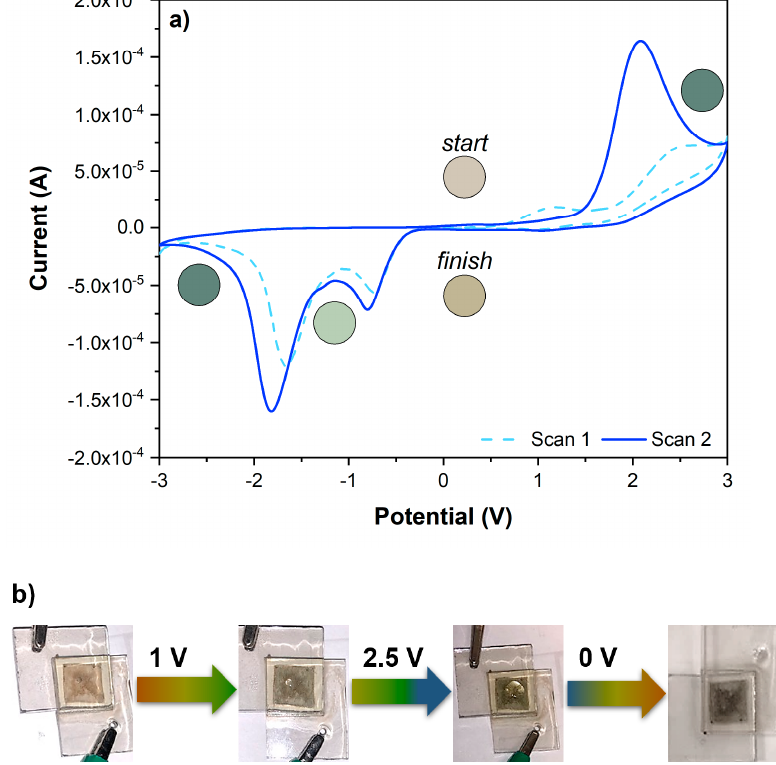
Figure 8. ( a ) Cyclic voltammograms of the two-electrode device with glass FTO/CBP/PVDF/FPOP electrode in a new electrolyte LiOTf:4EG at 20 mV s − 1 (first cycle: light blue dashed line; second cycle: blue solid line) and ( b ) a proof-of-concept of the ECD color change at different